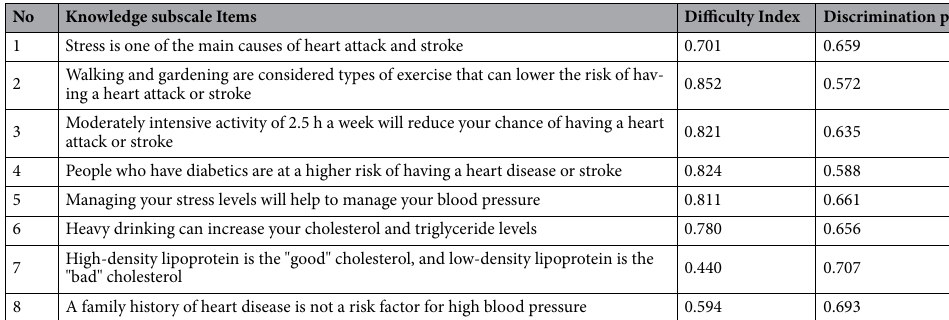
No Knowledge subscale